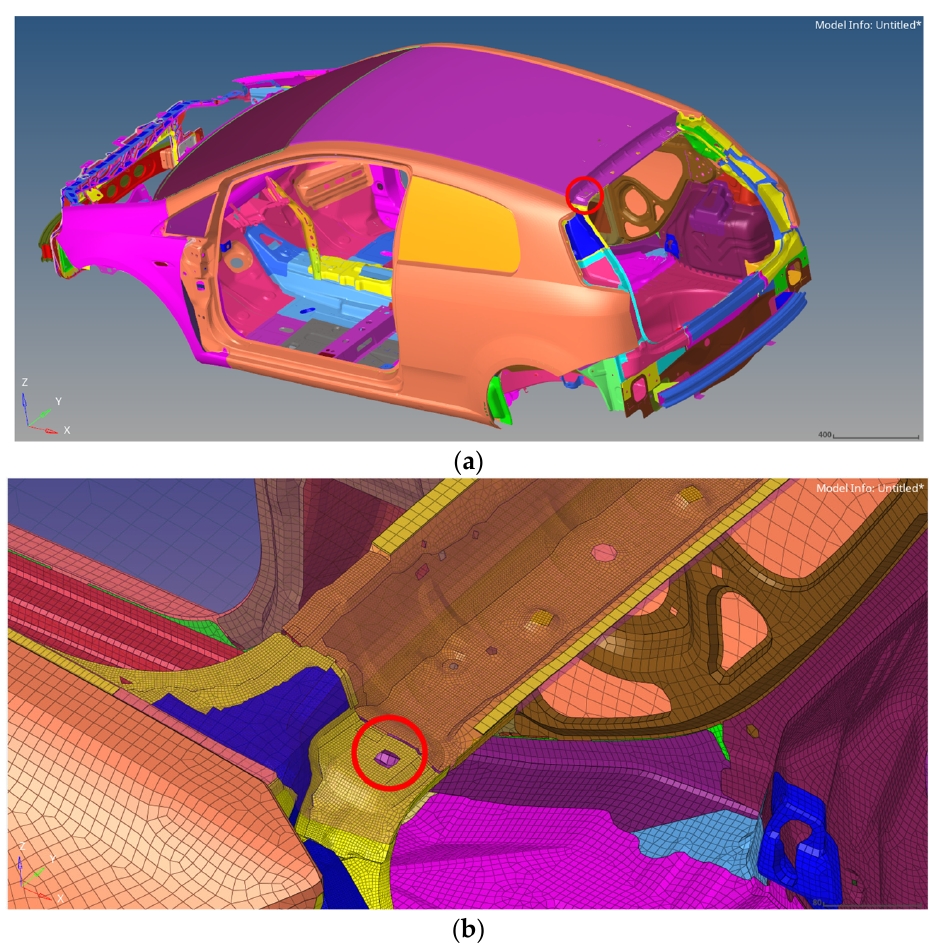
Figure 20. Left connection of the door hinge ( a ) with related close-up ( b ).